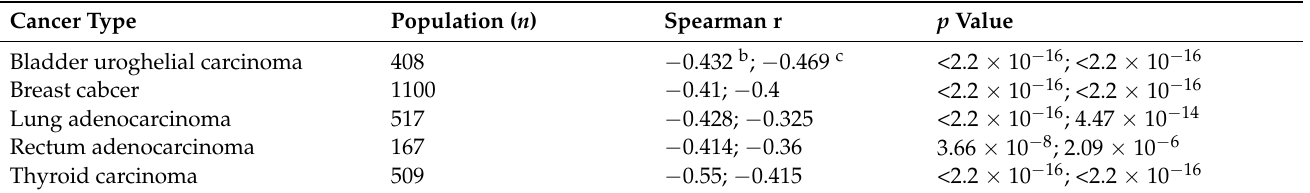
Table 1. Negative correlations between RKIP and PD-L1 and PD-L2 in cancers a